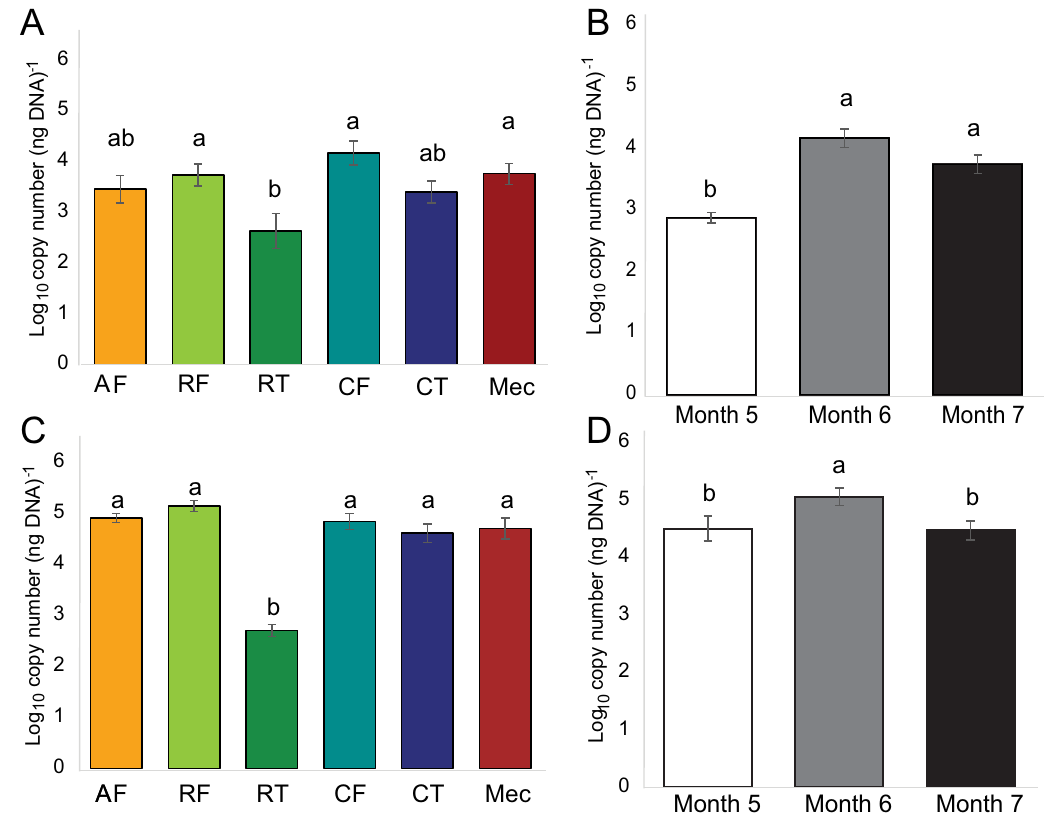
Figure 1. Quantitative PCR estimation (mean ± SE) of bacterial ( A , B ) and archaeal ( C , D ) 16S rRNA gene copy number in each GIT component and amniotic fluid ( A , C ) and at each gestational age ( B , D ). Amniotic fluid (AF), ruminal fluid (RF, n = 12), ruminal tissue (RT, n = 4), caecal fluid (CF, n = 8), caecal tissue (CT, n = 10), meconium (Mec, n = 11). Gestational age: 5 months ( n = 16), 6 months ( n = 18), 7 months ( n = 18). Different letters above bars indicate a significant difference ( p < 0.05) between means as determined via Tukey’s HSD and Dunn’s post hoc tests for bacterial and archaeal data,